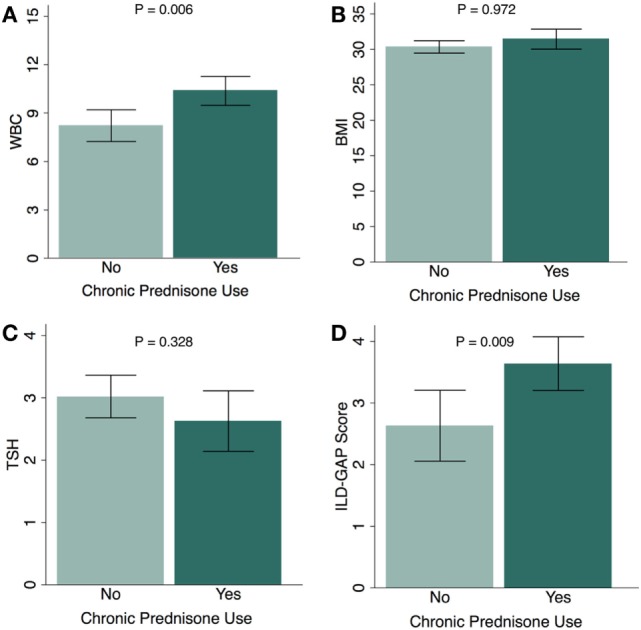
Chronic glucocorticoid use and physiologic parameters in chronic hypersensitivity pneumonitis (CHP) cohort. Relationship between chronic glucocorticoid therapy and (A) white blood cell count (WBC); (B) body mass index (BMI); (C) thyroid-stimulating hormone (TSH); and (D) ILD-GAP Score in patients with CHP. (Patients receiving chronic glucocorticoid therapy, N = 83; patients not receiving chronic glucocorticoid therapy, N = 38.) Exception for number of patients: WBC (n = 111), TSH (n = 86). Results are shown as mean ± SD.